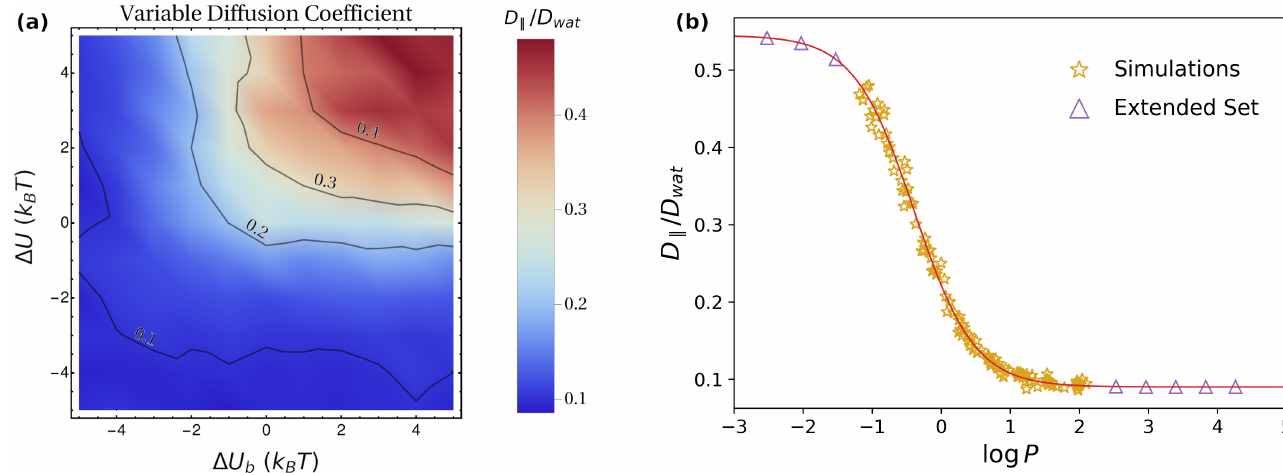
Figure 6. ( a ) Dependence of the parallel long-time diffusion coefficient D (cid:107) on hydropathy ( ∆ U ) and affinity for lipid heads ( ∆ U b ), implemented according to the corresponding potential of mean force U ( z ) (Figure 1a). The diffusion profile corresponds to Figure 1c with D lip = 0.09 D wat ; ( b ) dependence of D (cid:107) / D wat on log P for the simulation data (golden stars) and for an extended set of systems (purple triangles), for which the lateral diffusion coefficient was computed ac- cording to Equation (13). The extended systems with log P < 0 were obtained by considering ∆ U = ∆ U = 20 k > 0 were obtained by B T ,200 k B T ,2000 k B T ; the extended systems with log P b setting ∆ U = ∆ U b = − 10 k B T , − 9 k B T , − 8 k B T , − 7 k B T , − 6 k B T . The red continuous line